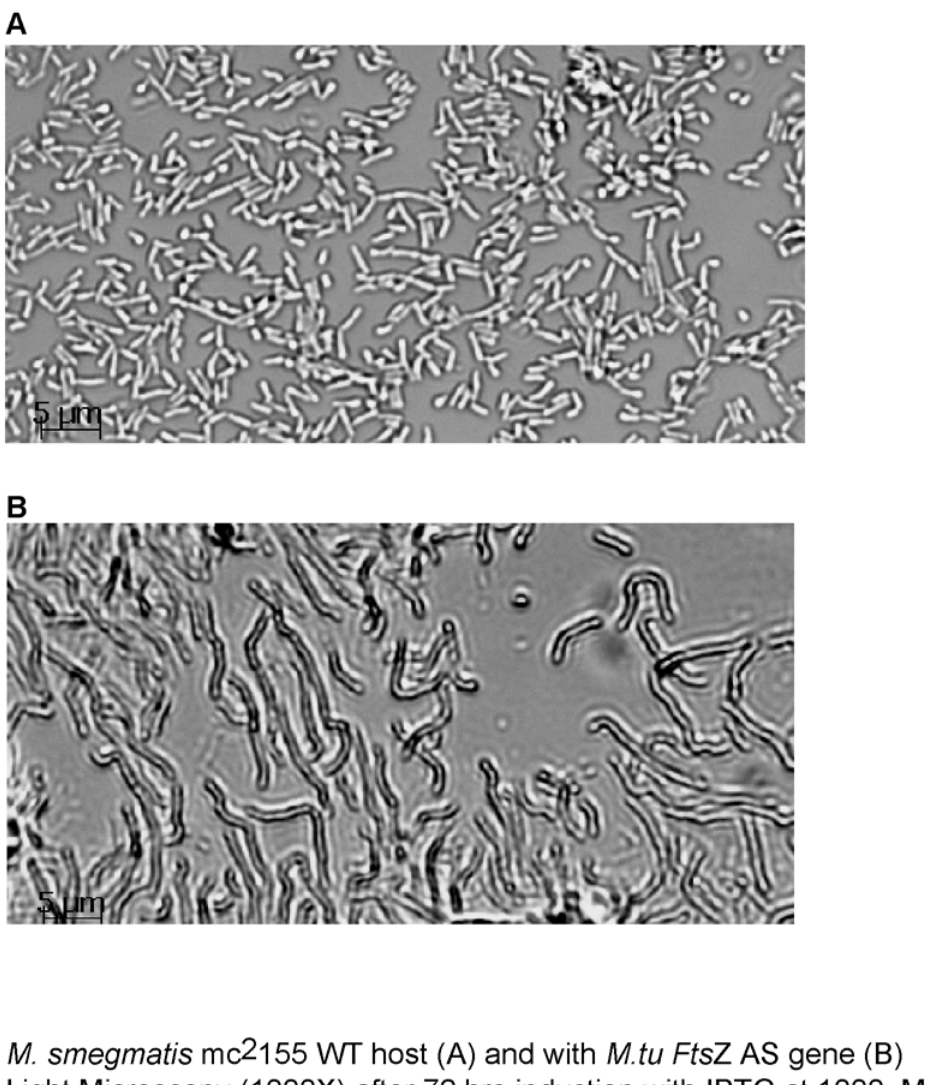
Figure 4. Fts Z antisense expression in mycobacteria. Microscopic (1000x) observation of M. tuberculosis Fts Z antisense construct in M. smegmatis mc 2 155: M. smegmatis mc 2 155 transformed with Mtu Fts Z antisense (AS) construct. The colonies appeared after 8 days ( vs .control in 3 days) & showed poor growth in broth (inhibited). Culture concentrated to normalize the cell number (vs. WT) for induction with IPTG. Panel A . M. smegmatis mc 2 155 host (WT) and Panel B . M. smegmatis mc 2 155 with Mtu Fts Z antisense gene, both induced for 48 hrs. with 1 mM IPTG. The induced cultures of Fts Z antisense clone ( Panel B ) showed filamentation with elongated cells (no septation), as observed under phase contrast conditions in 1000X. Micrographs were taken using AxioVision Rel. 4.5